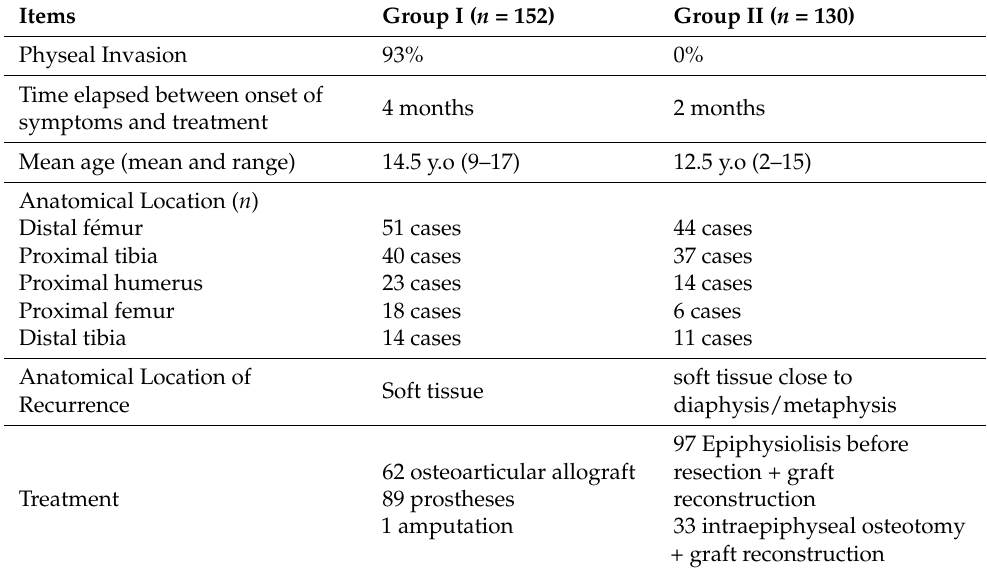
Figure 6. ( A ). MRI of a telangiectatic osteosarcoma crossing the growth plate. ( B ) The corresponding tumor can be observed. The arrows indicate where the tumor disrupts the physis. ( C ) Histological illustration of the finger-like projections of the osteosarcoma crossing the growth plate ( × 40). The recurrence incidence of Groups I and II was 12% and 8%, respectively. Local recurrences in Group I were observed in soft tissue while in Group 2 they were detected at the dysphisis or metaphysis; however, the patients with a tumor at the retained epiph- ysis did not show local recurrences. Most local recurrences appeared in the first 2 years. We only had 2 recurrences in a long term (9 and 10 years post-treatment). The disease-free survival was 59% in Group I and 73% in Group II, with a mean follow-up of 18 years. The more relevant clinical results are presented in the Table 1. Table 1. Comparison of various relevant aspects of Groups I and